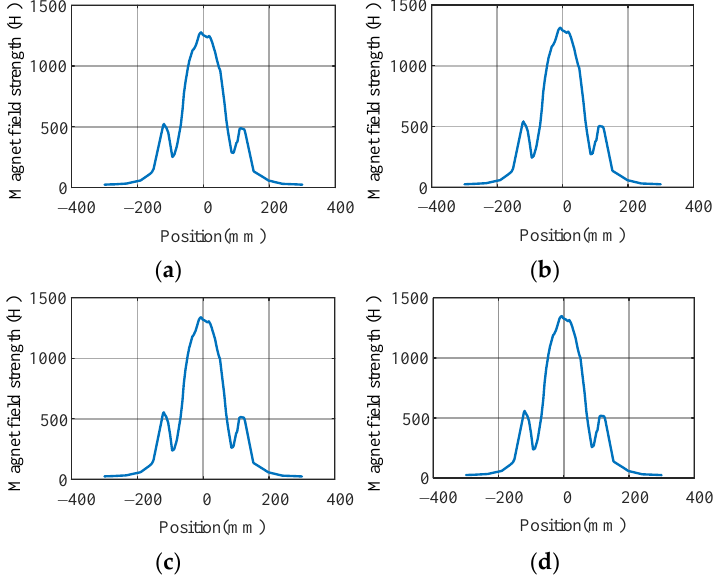
Figure A5. Magnetic field strength curves with different relative permeabilities of NiZn ferrite. ( a ) 250. ( b ) 500. ( c ) 900. ( d ) 1200.